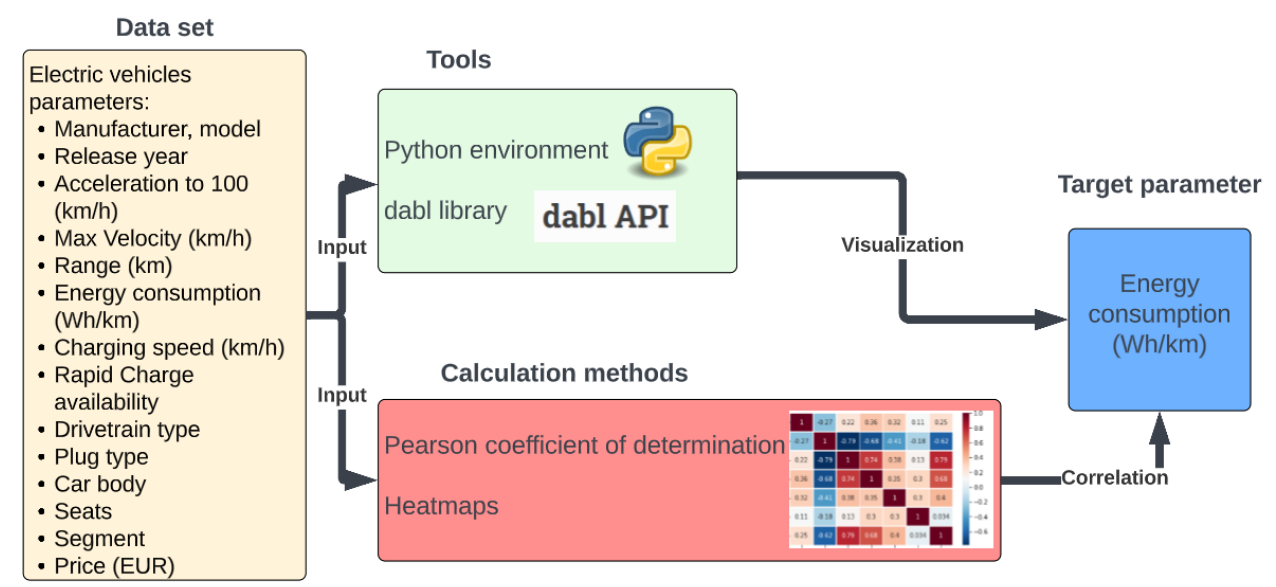
Figure 1. General structure of the work.